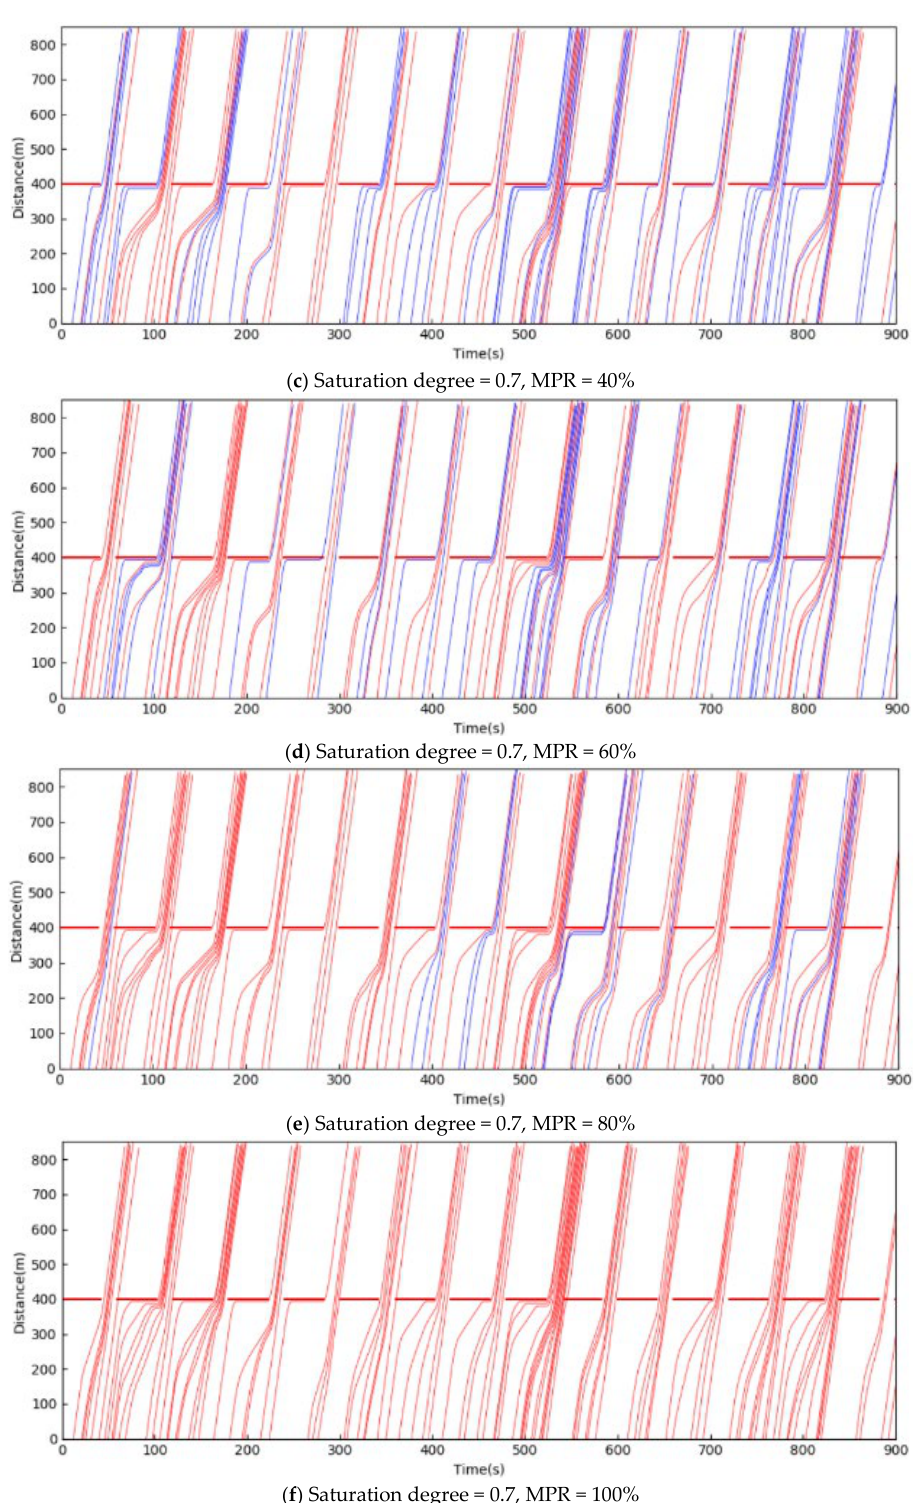
Figure 11. Spatial–temporal trajectories for different MPRs under the saturation degree of 0.7.